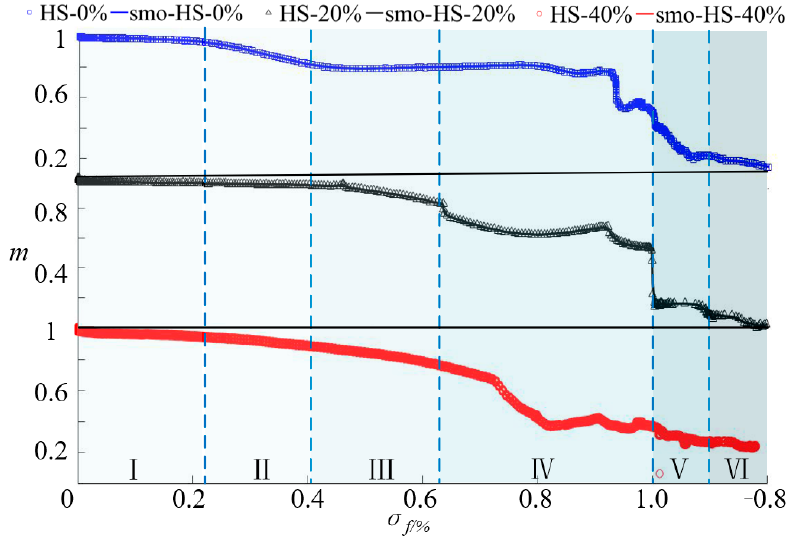
Figure 6. Grayscale mean–stress level curve. The grayscale entropy value refers to the degree of grayscale confusion, and the curve is shown in Figure 7. The grayscale entropy value indicates the change in energy during specimen deformation and failure. The falling curve indicates the energy dissipation of the specimen, and the rising curve indicates the energy accumulation. All ash entropy curves of the dry and moisture-bearing specimens show a decreasing trend with obvious changes in the first, third, and fourth stages that abide by the following trends: ① In Stage I, there is a chaotic and ordered fluctuation state of the dry specimen grayscale entropy curve. The accumulation and dissipation of microcrack pressure den- sity energy inside the specimen is stable at this stage, and the total energy inside the spec- imen remains stable. The 20%- and 40%-moisture-content specimens at this stage of the gray entropy curve experience a short fluctuation after a rapid rise in the specimen inter- nal water-filled microcrack. Additionally, the compression density process is short, and the energy accumulation leads to a rapid rise in the curve [23].